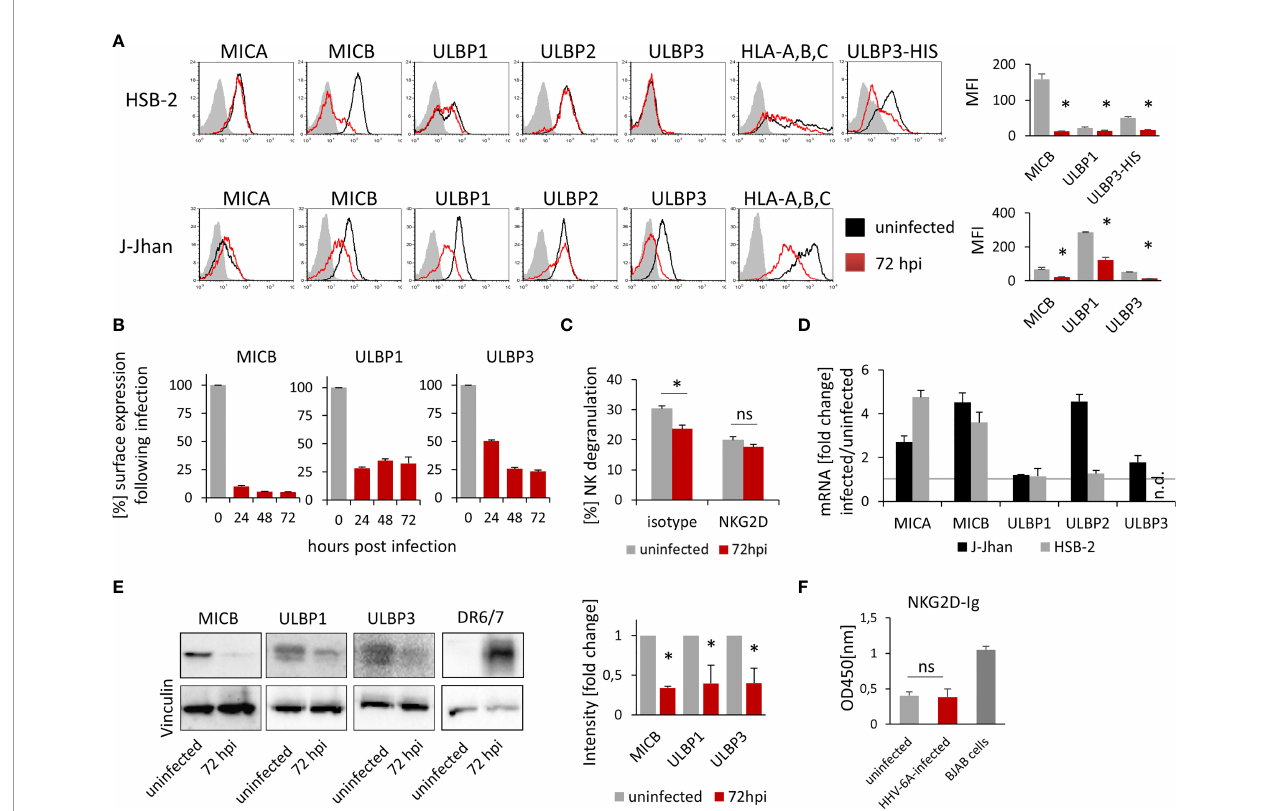
FIGURE 1 | Expression of three NKG2D ligands is affected during HHV-6A infection. (A) Detection of surface expression of MICA, MICB, ULBP1, ULBP2, ULBP3 and HLA class I on the T cell lines HSB-2 (upper panel) or J-Jhan (lower panel), either on uninfected cells (black histograms) or on HHV-6A infected cells at 72 hpi (red histograms). The grey shaded histogram is staining of an IgG isotype control on uninfected cells; the background of infected cells was virtually identical. Due to the lack of ULBP3 expression on HSB-2 cells, HSB-2-ULBP3 overexpression transfectants were stained as well. One representative experiment out of at least four is shown. Quanti fi cation of surface expression of MICB, ULBP1 and ULBP3 in uninfected cells (grey bars) and at 72 hpi (red bars) is shown on the right. Averages using median fl uorescence intensity of at least 4 experiments were used, *p < 0.005 in student ’ s t-test. (B) Surface expression of MICB, ULBP1 and ULBP3 kinetics in J-Jhan cells presented as median fl uorescence intensity over time. (C) NK cell degranulation towards uninfected (grey bars) or HHV-6A infected or J-Jhan cells at 72 hpi (red bars) in presence of an isotype IgG antibody (left) or a NKG2D blocking antibody (right). Data is merged from four independent experiments and standard error of means is shown, *p < 0.05 in student ’ s t test; ns = not signi fi cant. (D) qRT-PCR analysis of mRNA levels of MICA, MICB, ULBP1, ULBP2 and ULBP3 in J-Jhan cells (black bars) and HSB-2 cells (grey bars). Shown are relative values of HHV-6A infected cells at 72 hpi compared to uninfected cells (=1, grey line) normalized to HPRT. GAPDH was used as additional internal control and yielded similar results. ULBP3 mRNA levels in HSB-2 cells were insuf fi cient to yield reliable results in qRT-PCR, n.d. = not detected. Averaged data out of at least three experiments including standard error of the mean is shown. (E) Western Blot analysis of MICB levels in HSB-2 cells as well as ULBP1 or ULBP3 in J-Jhan. Cells were infected for 72 hours prior to sample preparation. One representative experiment out of three is shown. Quanti fi cation was statistically analyzed using a single sample t-test, *p (MICB) = 0.01, *p (ULBP1) = 0.04, *p (ULBP3) = 0.03. (F) ELISA for soluble NKG2D ligands in supernatants of uninfected or HHV-6A infected J-Jhan cells using an NKG2D-Fc fusion protein. Merged data from three independent infections is shown. BJAB cell supernatants served as positive control. Differences between uninfected and infected cells were not signi fi cant (ns) according to the student ’ s